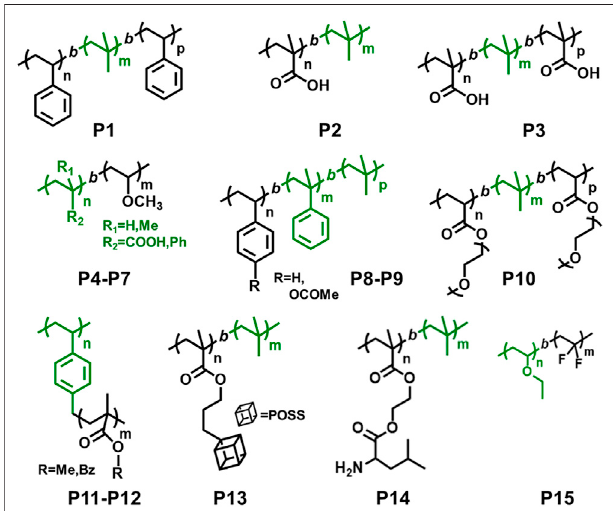
FIGURE 3 | Examples of block copolymers synthesized via combination of living cationic polymerization and controlled/living radical